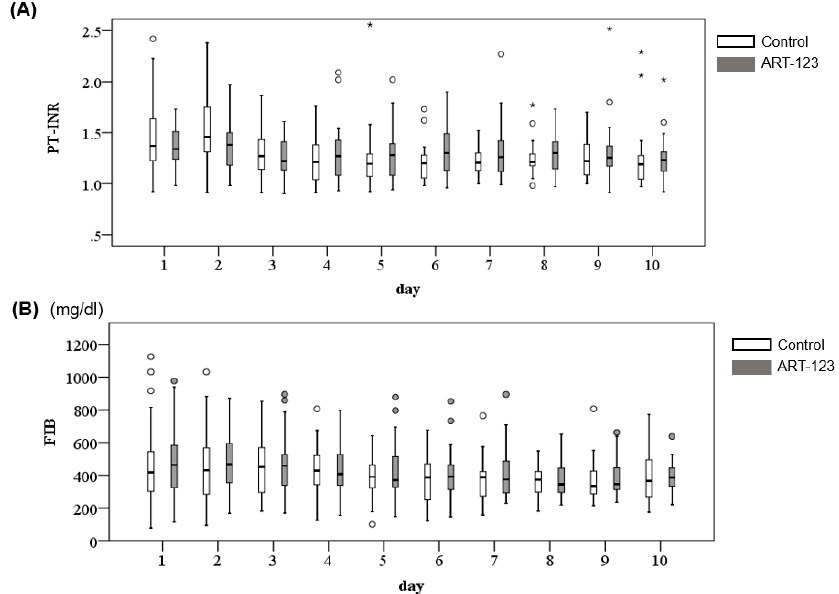
Figure 5. Changes of time course in prothrombin time-international normalized ratio (PT-INR) ( A ) and fibrinogen (FIB) ( B ).